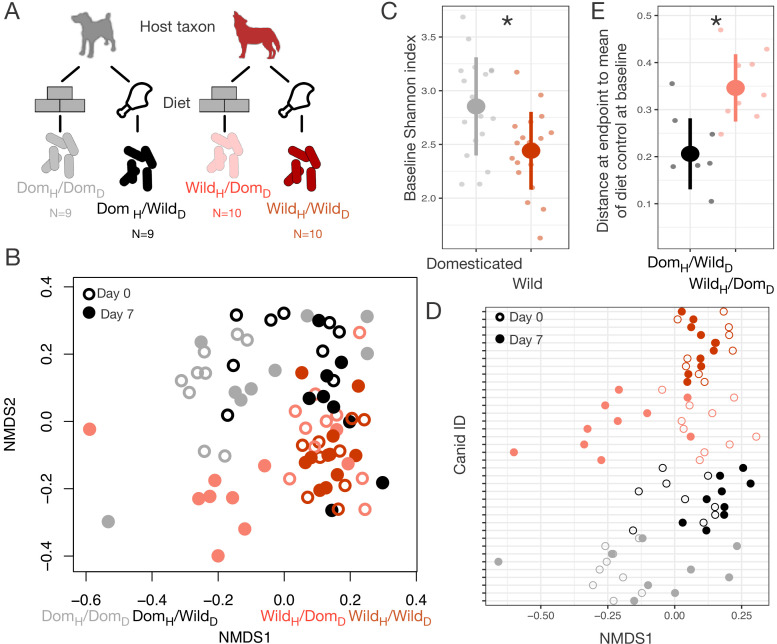
Microbial differences between wild and domesticated canids can be partially overcome by diet shifts.(A) Design scheme for fully factorial host taxon by diet canid experiment (N = 9 dogs or N = 10 wolves per diet group). (B) Nonmetric multidimensional scaling (NMDS) ordination of Bray–Curtis dissimilarities showing changes for canids from day 0 (open circle) to day 7 (filled circle) by experimental groups (color). Composition varied by host taxon (p<0.001, R2 = 0.098, F = 13.70, permutational MANOVA), diet (p<0.001, R2 = 0.058, F = 8.15), and a host taxon by diet interaction (p<0.001, R2 = 0.028, F = 3.93). (C) Shannon index differed between dogs and wolves on day 0 (p=0.003, Mann–Whitney U test). (D) Canids on reciprocal diets (DomH/WildD and WildH/DomD) but not control diets moved in opposite directions along Bray–Curtis ordination NMDS axis 1 over time (p=0.004 and 0.002, respectively, one-sample Wilcoxon tests). (E) At the end of the experiment, distance to the mean of diet controls at baseline (DomH/DomD and WildH/WildD) was lower for dogs than for wolves on reciprocal diets (p=0.001, Mann–Whitney U test). * indicates p<0.05, Mann–Whitney U test. Large circles are means; bars show standard deviations.